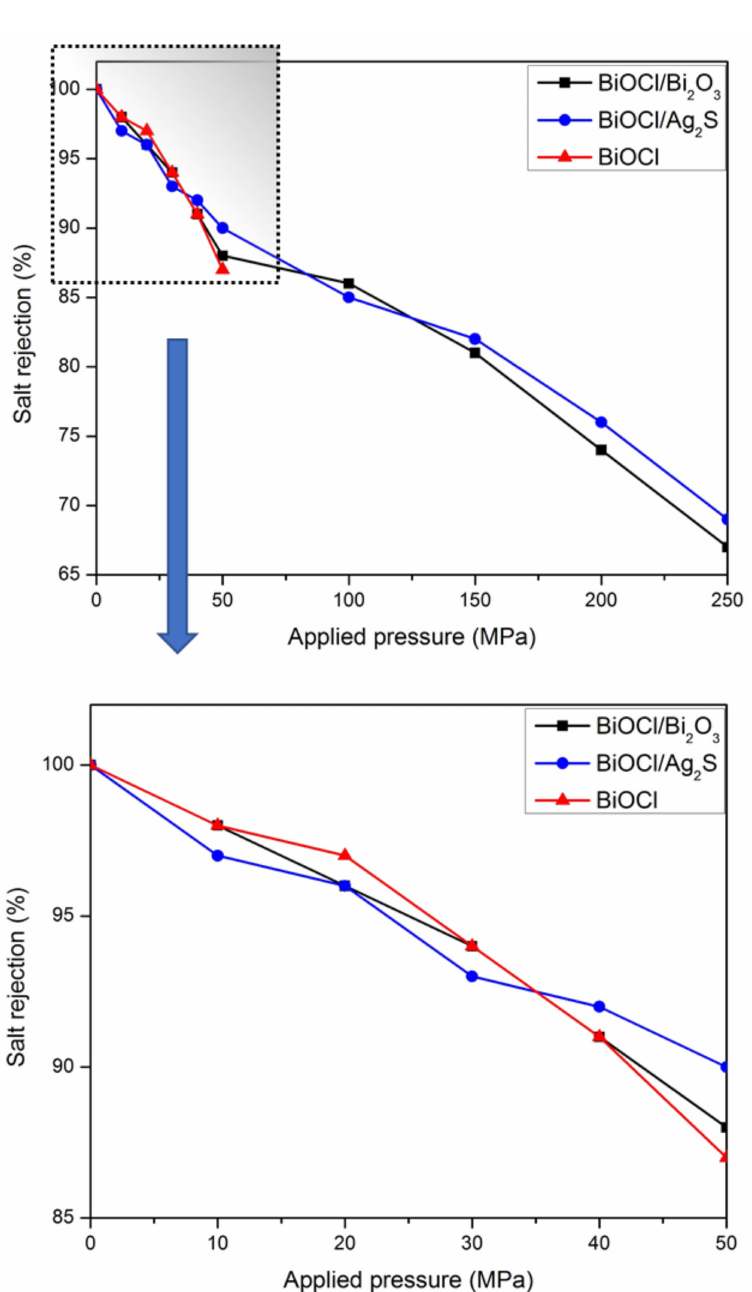
Figure 10. Salt rejection rate of membranes under the suggested external pressure between 50 and 25